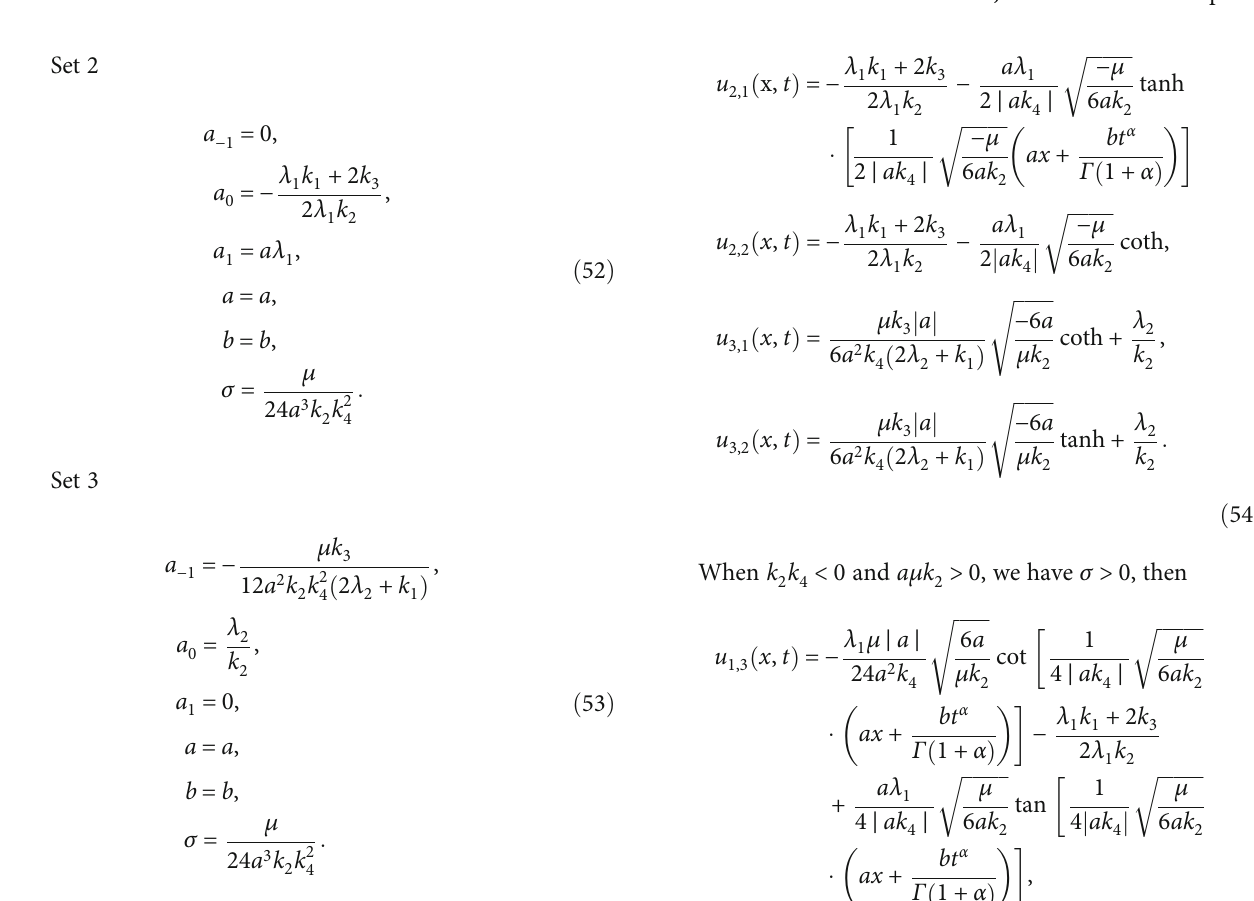
ffiffiffiffiffiffiffiffiffi μ